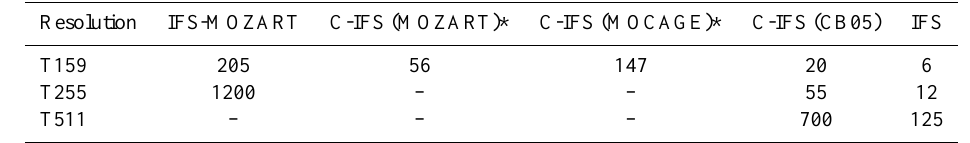
Table 3. Computational cost (BU) of 24h forecasts of different horizontal model resolutions (60 levels) and chemistry schemes of C-IFS, IFS-MOZART and IFS, *not fully optimised.